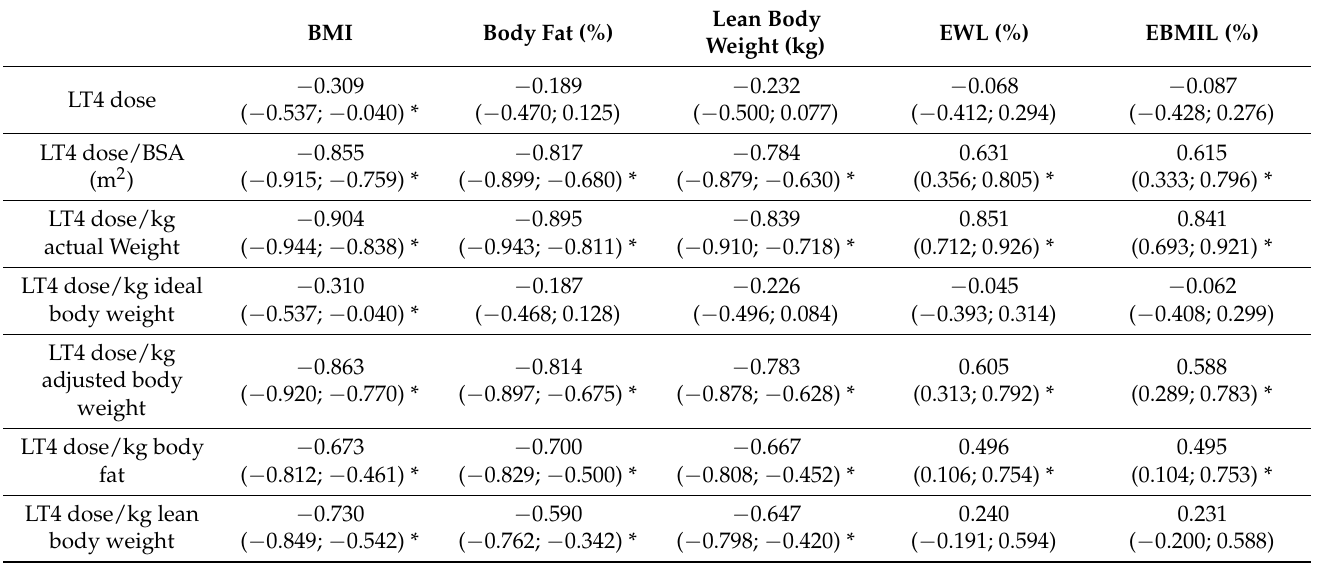
Table 6. Correlation between levothyroxine (LT4) dose change in hypothyroid patients and variation in anthropometric parameters after bariatric surgery. Values shown are repeated measures correlation coefficients together with their 95% confidence